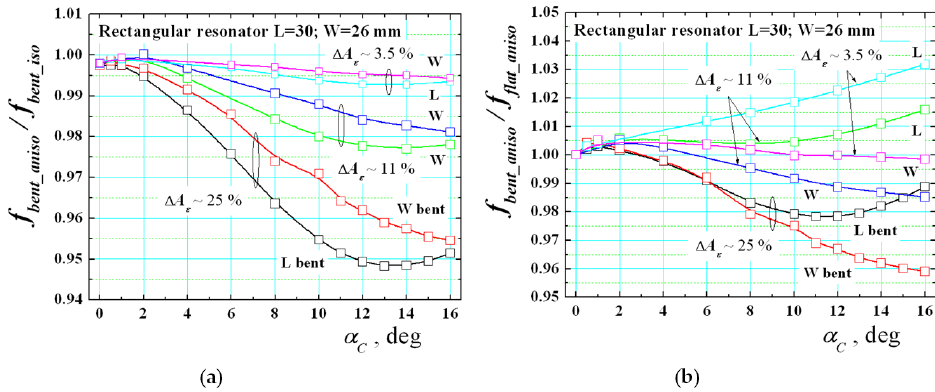
Figure 15. ( a ) Numerical dependencies of the ratio f bent_aniso / f bent_iso between the resonance frequencies of mode TM 10 in L/W-bent resonators on anisotropic and isotropic substrates ( h s = 0.52) versus the curvature angle α C ; ( b ) Numerical dependencies of the ratio f bent_aniso/ f flat_aniso of mode TM 10 in L-/W-bent and flat rectangular resonators on anisotropic substrates versus the curvature angle α C Figure 15b presents the ratio f bent_aniso/ f flat_aniso between the resonance frequencies of mode TM 10 for L-/W-bent rectangular resonators on anisotropic substrates versus the cur- vature angle α C . Now, this ratio is measurable and can be verified experimentally. The